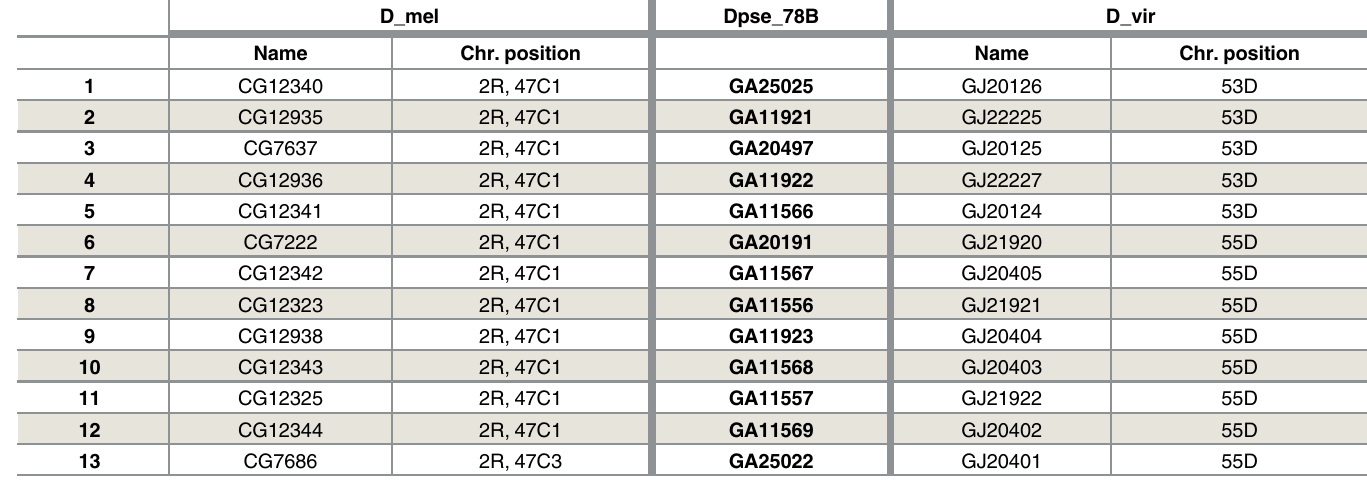
Table 4. List of D . pseudoobscura genes at Dpse_78B orthologous to genes of D . virilis and D . melanogaster